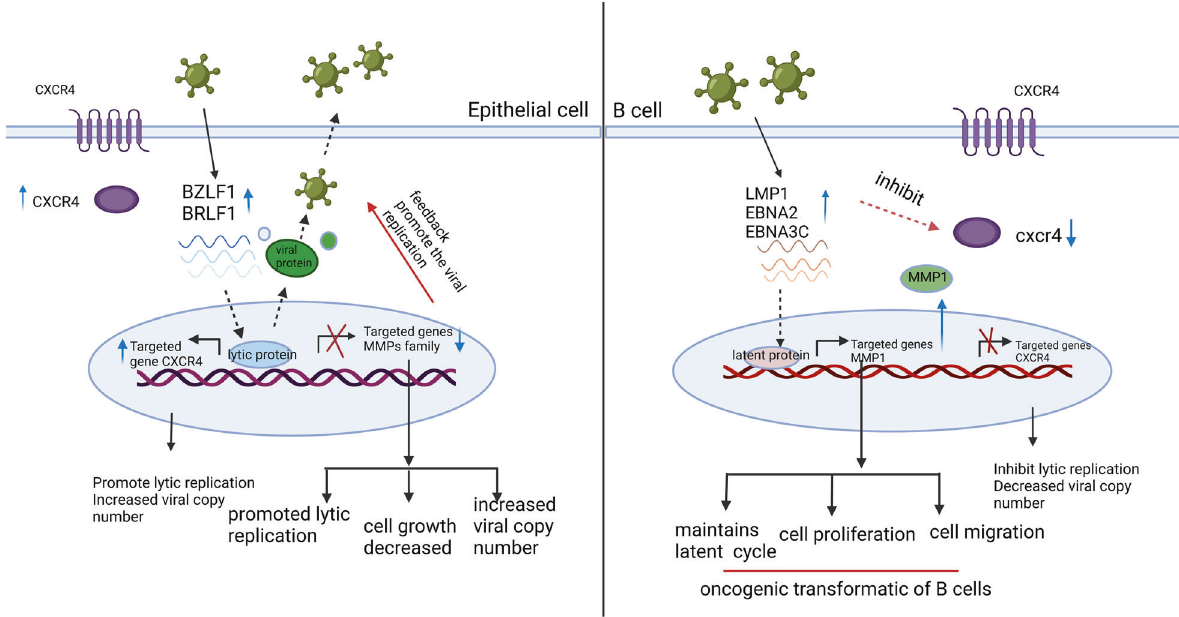
expressed in NOKs and PBMCs, and in turn they would induce different cellular responses through dysregulation of different pathways. This activation leads to the expression of different downstream genes including MMP1 and CXCR4 ranked among the top 10 signi fi cantly affected in NOKs and PBMCs, respectively. During the primary infection, we found that MMP1 was increased in PBMCs, which can promote and sustain the latent cycle in EBV positive B cells. However, we also found that CXCR4 was inhibited by the latent viral protein of EBV in EBV positive B cells, which resulted in inhibition of the lytic state and viral replication. The two genes show opposite expression when epithelial cells are infected, so they played a different role in these two different cell lines. For the EBV positive NPC cells, we found that cell proliferation was decreased following MMP1 knockdown in EBV positive cell lines. Meanwhile, EBV lytic gene expression was signi fi cantly increased. During our investigation of EBV lytic genes in NPC cells, CXCR4 knockdown resulted in decreased EBV lytic gene expression. However, CXCR4 had a signi fi cant impact on cell proliferation in NPC43 and C17 cell